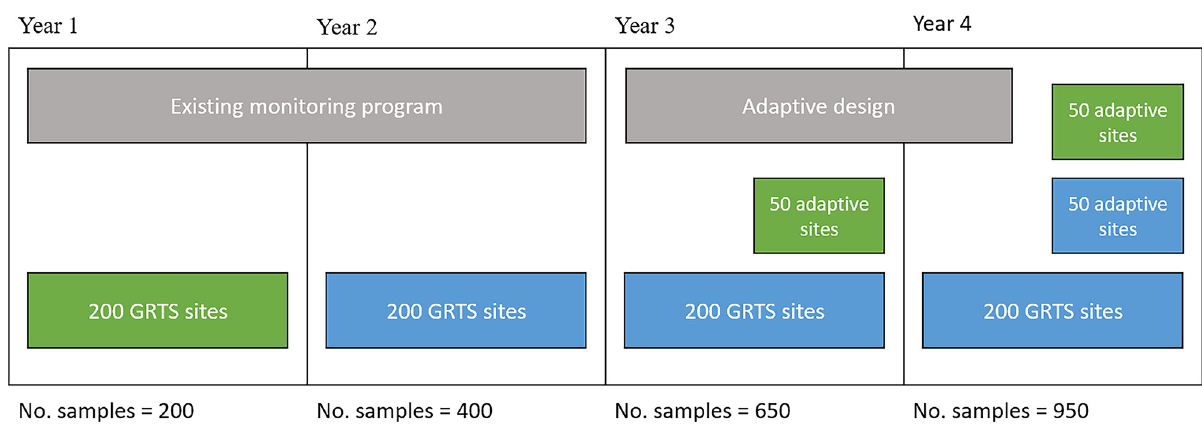
Fig 5. A schematic diagram showing the adaptive design process over four years. Green rectangles indicate new sites (i.e. sampling locations) that have been added to the monitoring program, and blue rectangles indicate that sites have been retained from previous years.